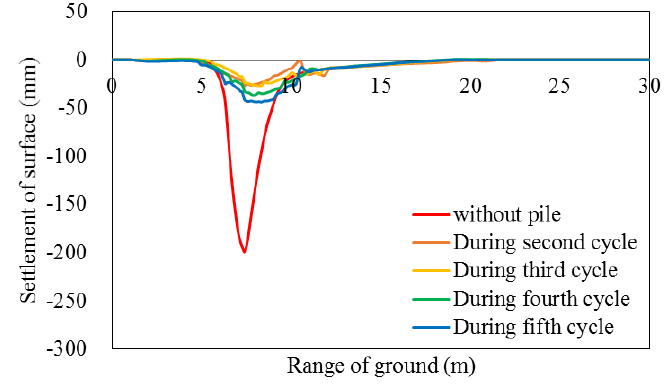
Figure 17. Surface settlement trough according to progress of construction step at cover depth of 1.5 m. Figure 18. The stress contours in two or three nearest piles from the tunnel face were represented with blue color because these piles were bent downward, which helped to restrain the ground